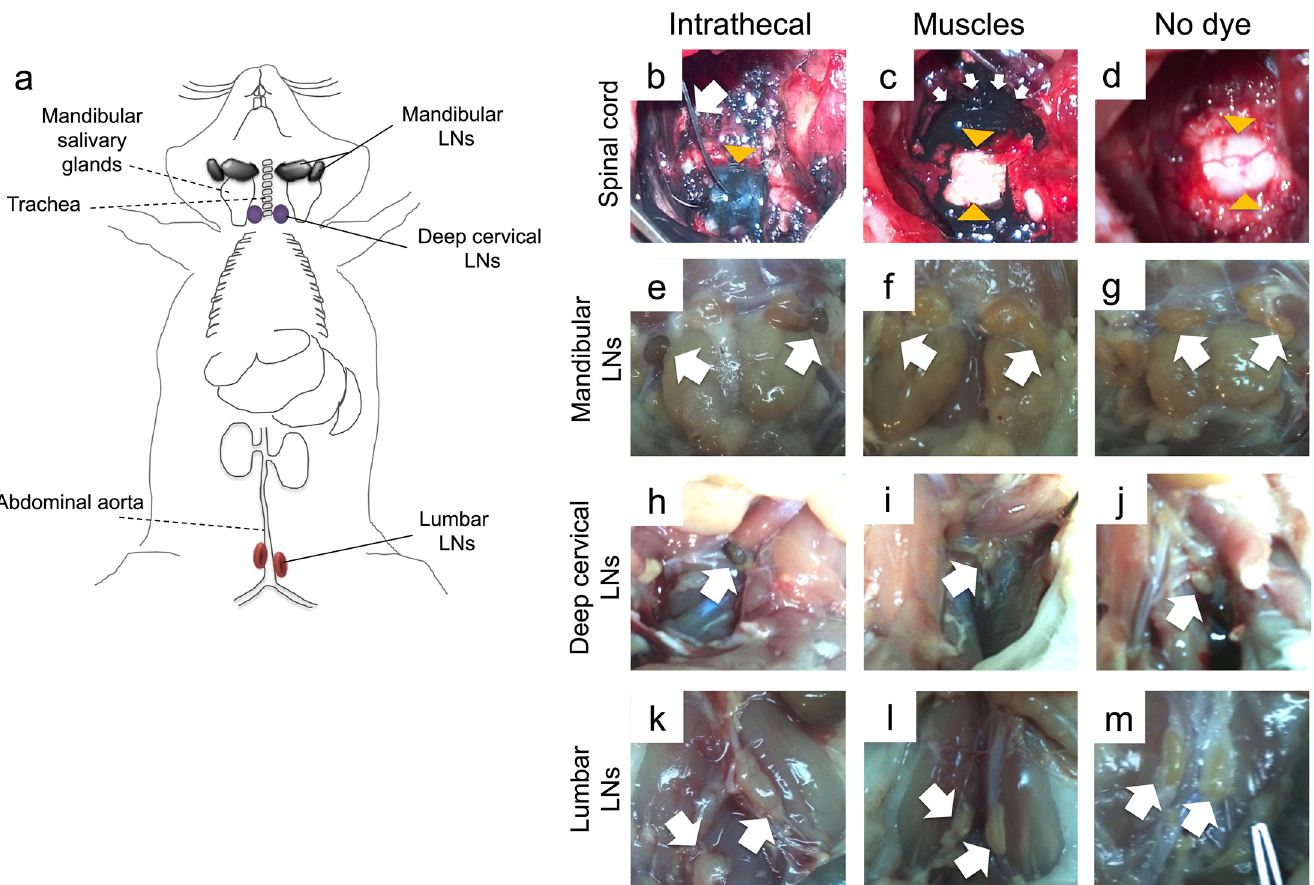
Fig 1. Locating LNs that drain the cervical spinal cord following intrathecal infusion of india ink. (a) Schematic drawing of rat LNs assessed macroscopically (solid lines) and respective anatomical landmarks (dotted lines). Mandibular LNs, herein referred to as mandibular and accessory mandibular LNs collectively [21], are located adjacent to and rostromedially from the sublingual and mandibular salivary glands. Cranial deep cervical LNs (referred to as deep cervical LNs) are dorsal to the trachea, and lumbar aortic LNs (here referred to as lumbar LNs) are adjacent to the abdominal aorta. (b) India ink was infused intrathecally by a catheter, which was inserted through a small hole in the dura at the C7/T1 level. The white arrow shows the catheter and the yellow arrowhead indicates the spinal cord, which is stained by the dye below the dura. (c) In control rats, the dura remained intact and the dye was allowed to diffuse in the surrounding muscles (white arrows), leaving the spinal cord unstained (yellow arrowheads). (d) In the third group, which received no dye, both the spinal cord (arrowheads) and muscles were unstained. (e-j) (e) Mandibular LNs and (h) deep cervical LNs of rats receiving intrathecal dye were consistently stained blue/black, but these LNs remained unstained in the (f, i) muscle control and the (g, j) no dye groups. (k-m) Lumbar LNs remained unstained in all